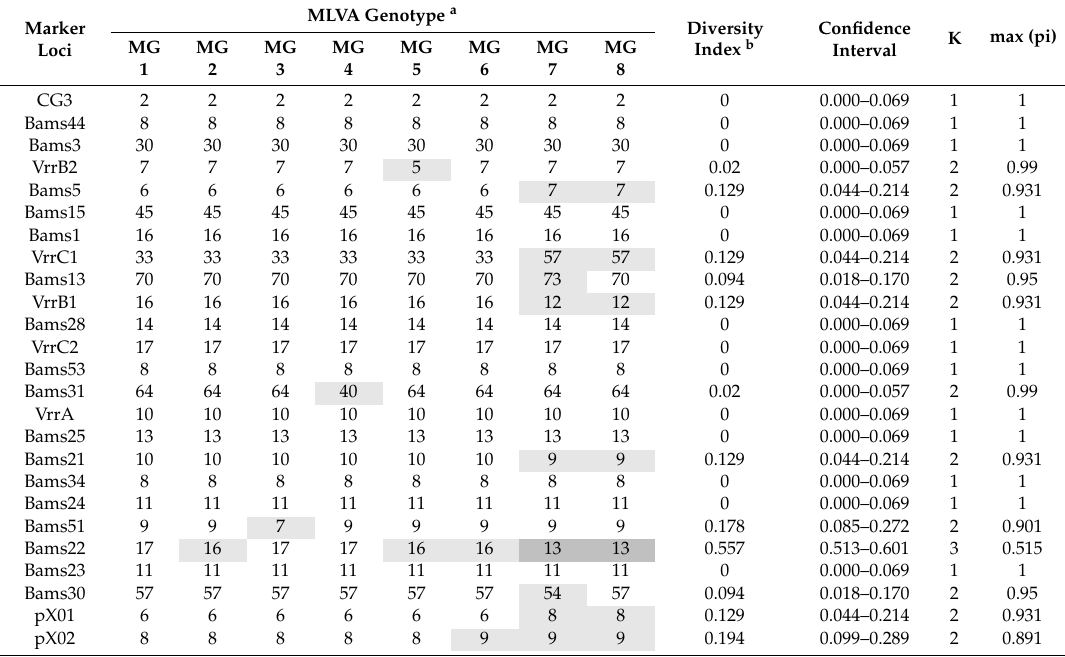
Table 2. Multilocus genotypes of Australian Bacillus anthracis isolates and diversity indices for each marker locus for the B. anthracis isolates